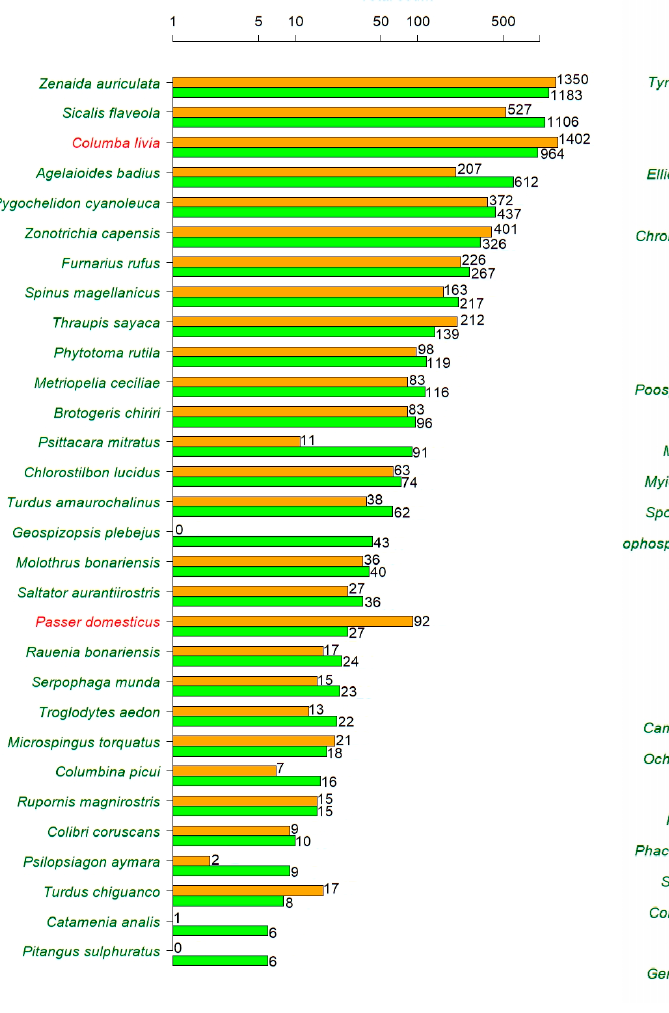
Figure 3. Total counts of bird species individuals in the natural (green) and artificial (orange) sections, with the color of the species names indicating status (green: native; red: introduced). Table 2. Output summary of the canonical redundancy analysis of bird communities (formula: ma- trix of bird observations ~ noise + section type + CV of DBH).